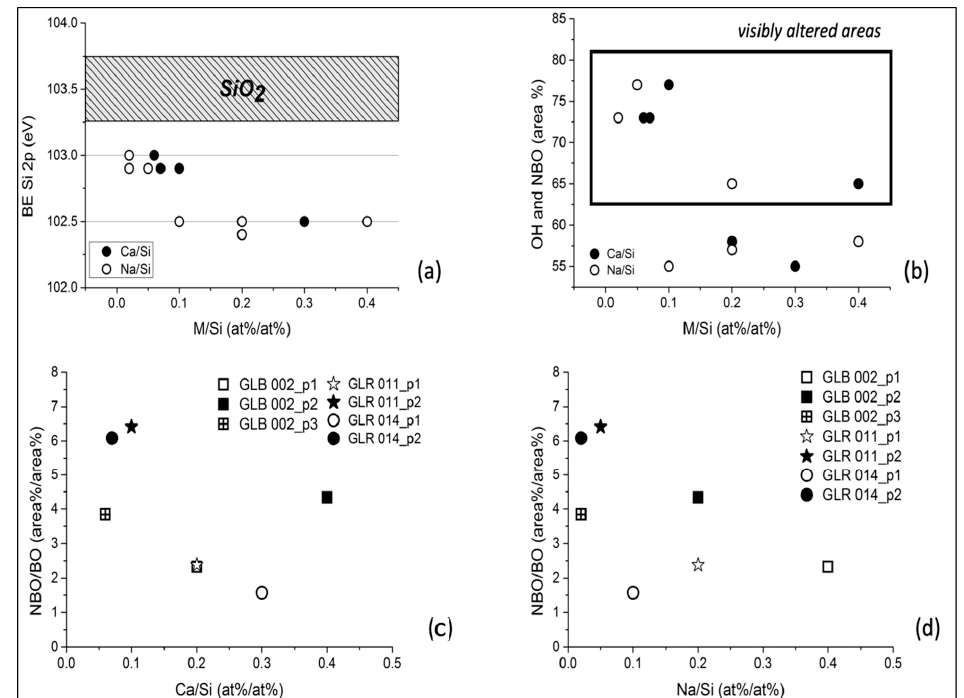
Figure 12. ( a ) binding energy (BE) of XPS Si 2p peak versus cation/Si ratios. The shaded area represents the range of BE reported in literature for SiO2. [50] [ref: https://srdata.nist.gov/xps/selEnergyType.aspx]; ( b ) Area % of non-bridging and OH component in O 1s peak vs Ca/Si and Na/Si ratios; ( c ) non-bridging/bridging oxygen area ratio from O 1s peaks vs Ca/Si ratios and ( d ) Na/Si ratios.